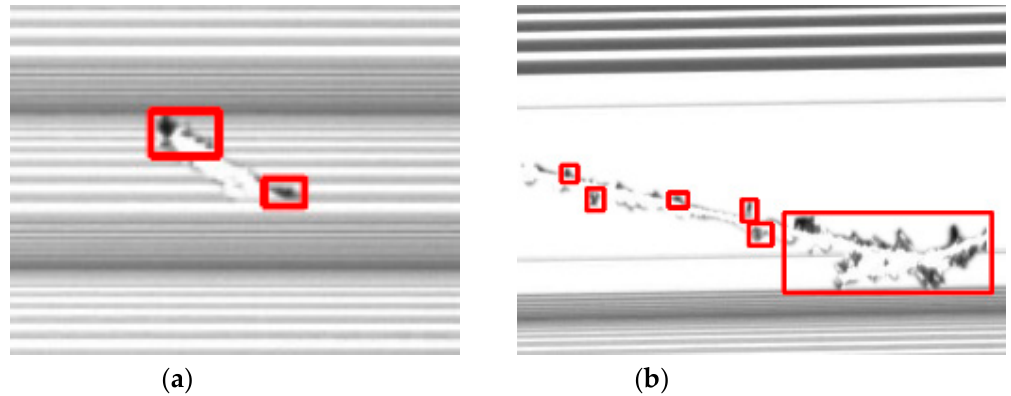
Figure 20. The enlarged scratches that the proposed algorithm failed to detected: ( a ) in the block, and ( b ) in the interval.